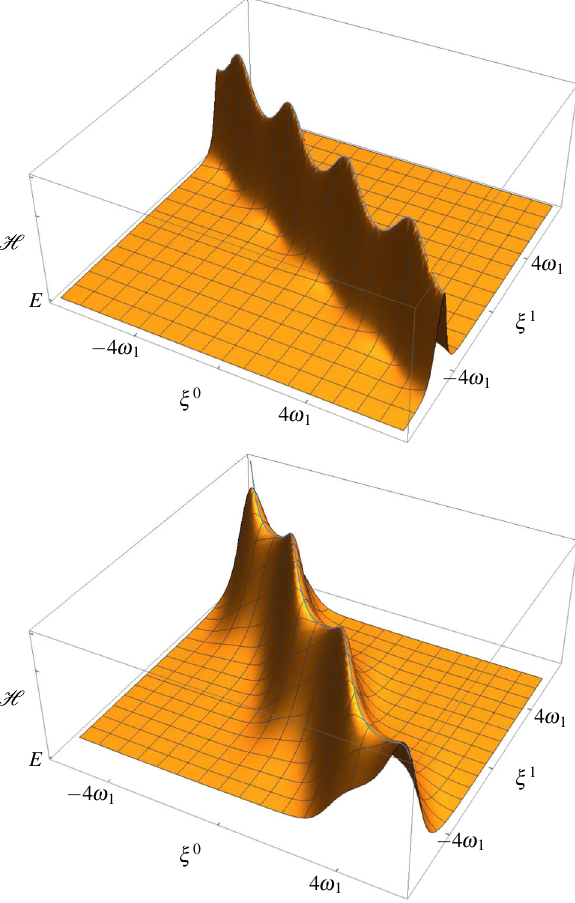
Fig. 6 The energy densities of the dressed elliptic solutions with trans- lationally invariant seeds depicted in Fig.